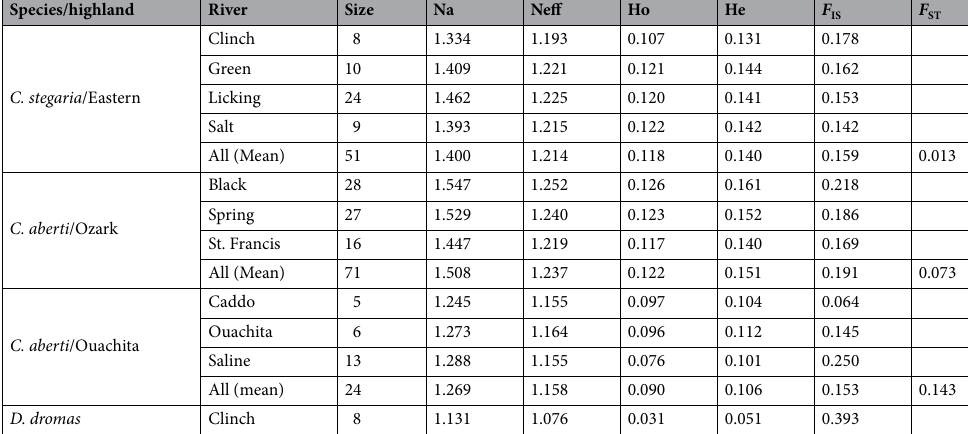
Table 1. Measure of genetic Diversity and inbreeding coefficient for populations from rivers, Highlands and species. A total of 154 individuals except two geographically isolated individuals (Ozark_105 and Ozark_107) were included in this analysis. Na mean number of alleles, Neff effective number of alleles (The number of alleles in a population, weighted for their frequencies), Ho observed heterozygosity, He expected heterozygosity assuming Hardy–Weinberg equilibrium, F IS inbreeding coefficient, F ST uncorrected for missing data.